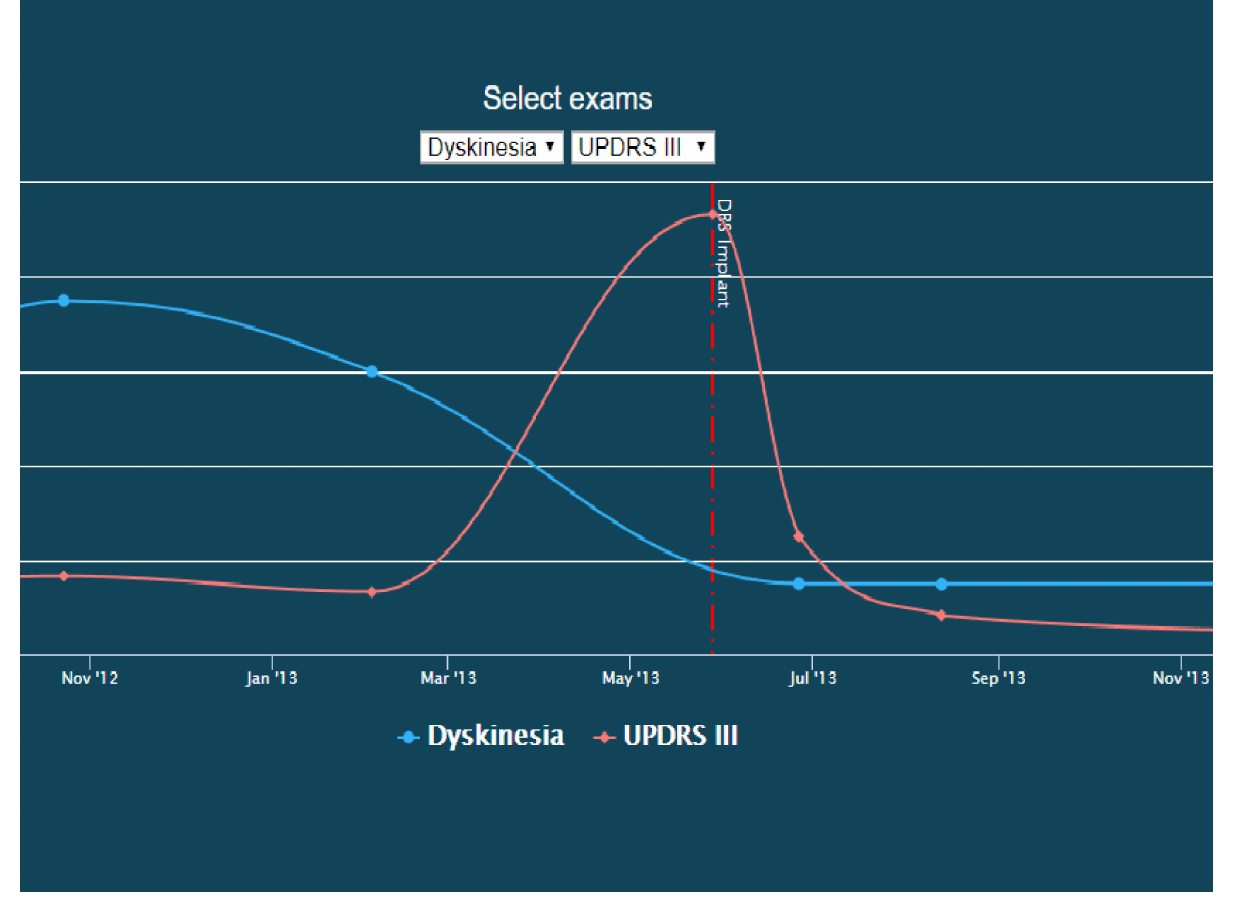
FIGURE 4 | Screenshot of a patient timeline. In this image, dyskinesia exam scores are co-plotted with UDPRS III scores over time, illustrating their temporal relationship with the start of DBS therapy. This image is available on the INR website as an interactive explorer, where the user can control what is being plotted over